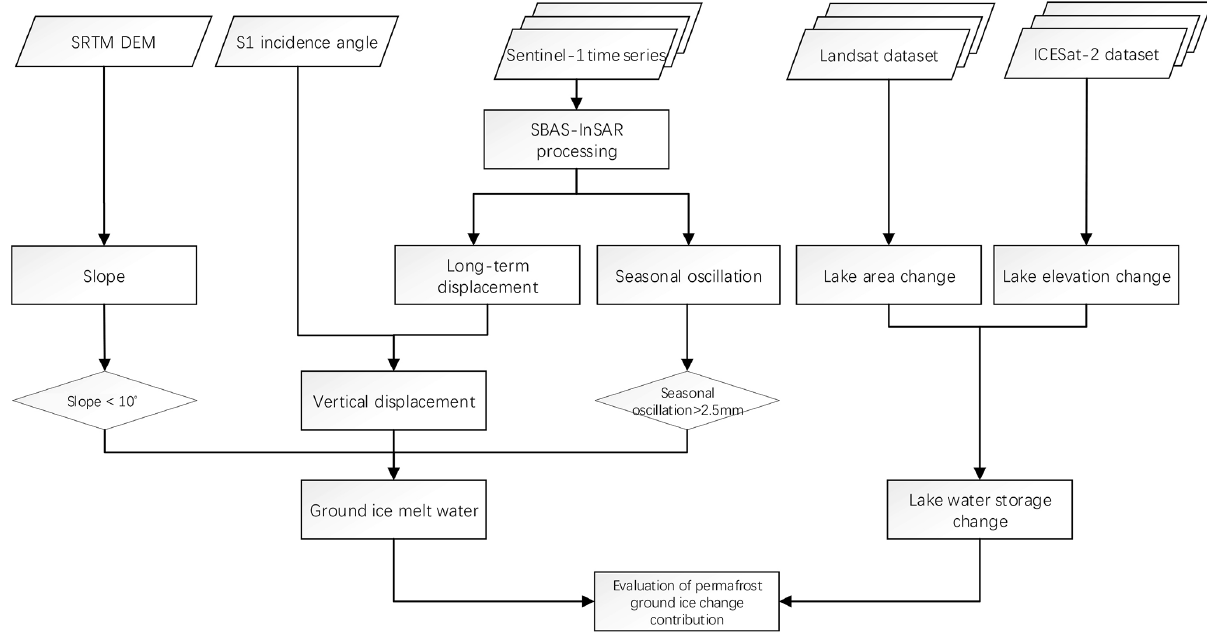
Figure 3. Workflow of estimating the water contribution by permafrost ground ice melting to the expansion of Selin Co.